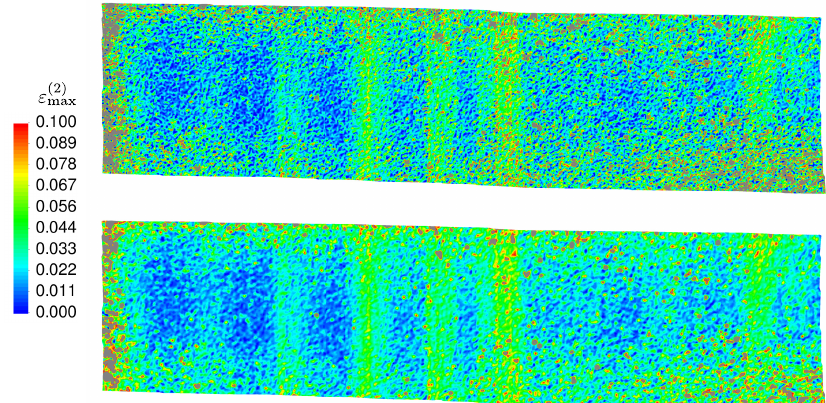
Figure 11. Comparison of ( bottom ) triangulation result for torsion and ( top ) RBF (IMQ + Mon) showing principal maximum Green strain ε plane and rotated by 90° to reduce the figure size).